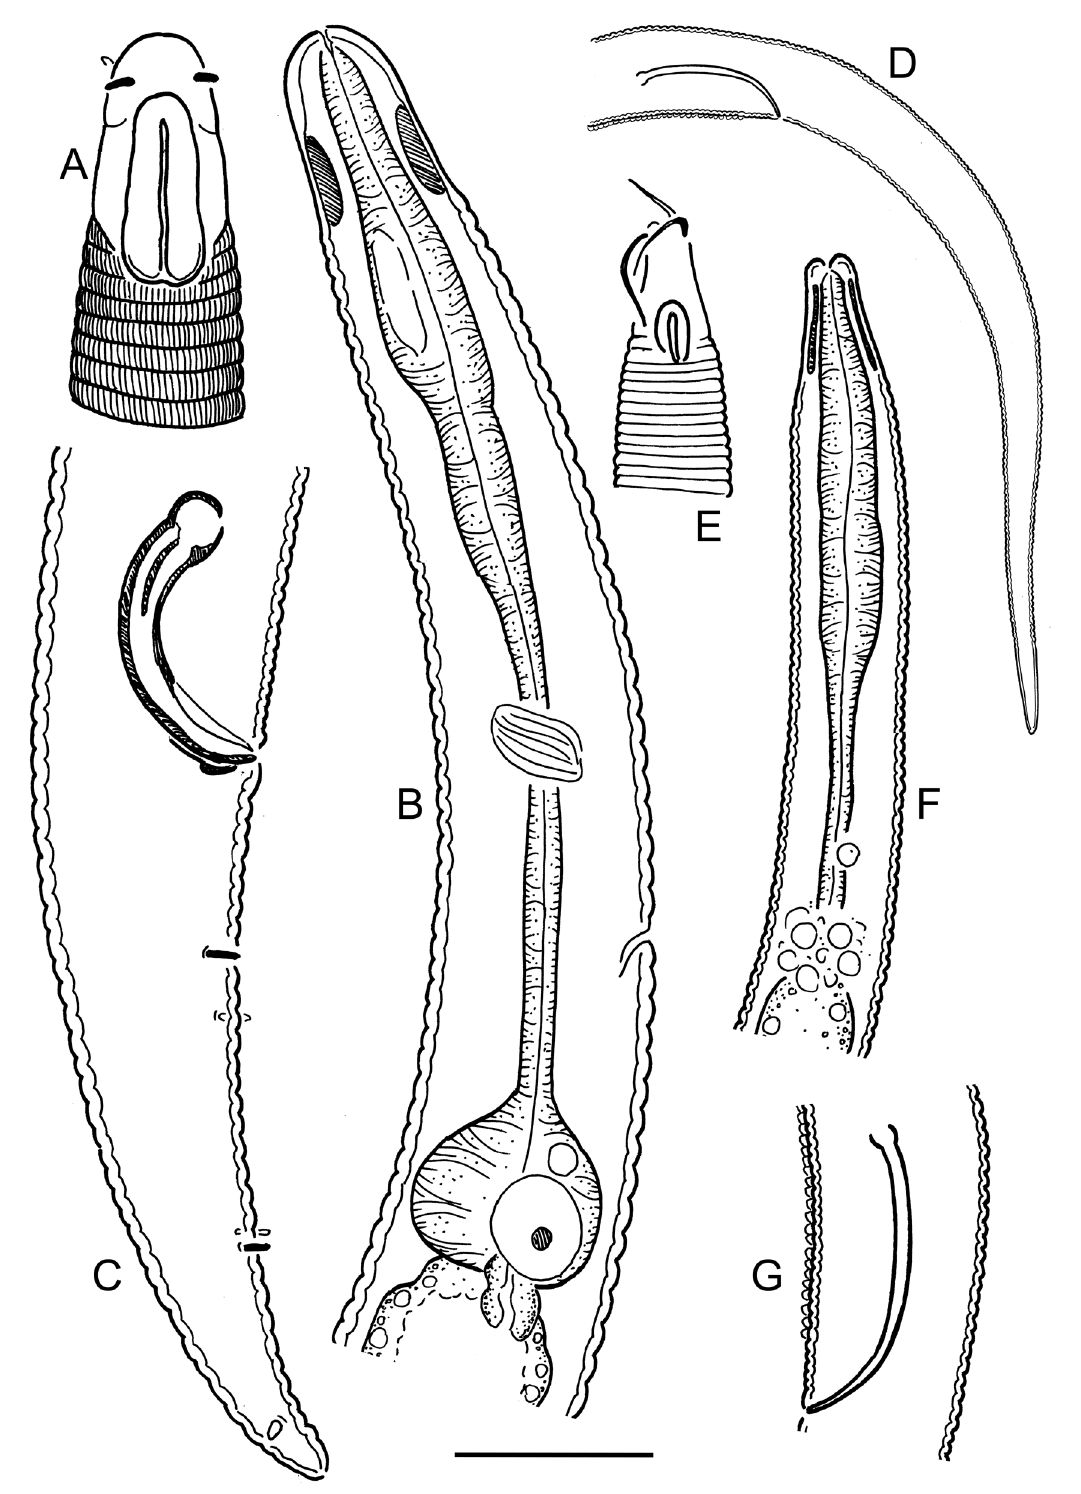
Fig. 9. A–C . Diplopeltoides linkei Jensen, 1991, male. A . Anterior end, surface view. B . Pharyngeal region, optical median section. C . Tail. — D–G . Diplopeltoides longicaudatus sp. nov., male. D . Tail. E . Anterior end, surface view. F . Pharyngeal region, optical median section. G . Cloacal region. Scale bar: A–C, E–G = 20 µm, D = 40